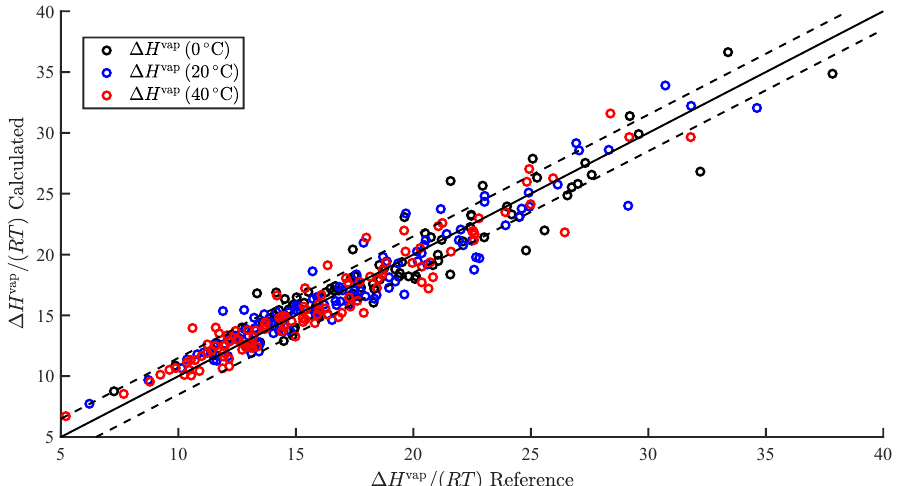
Figure 3. Parity plot of the dimensionless ∆ H vap / ( RT ) calculated using Equation (14) at 0, 20, and 40 ◦ C, as indicated, versus the reference values. The solid line corresponds to the y = x line, and the dashed lines correspond to plus or minus the root-mean-squared error (RMS) at 20 ◦ C and are drawn as a